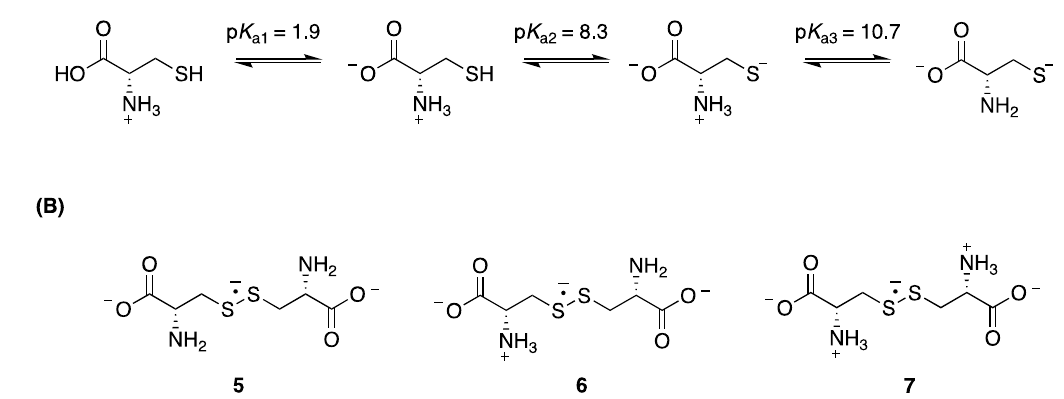
Figure 2. ( A ) The structure of cysteine, CysSH, and associated p K a values; ( B ) Disulfide radical anion of cysteine (CysSSCys) •− with 0 ( 5 ), 1 ( 6 ), and 2 ( 7 ) protonated amino groups.